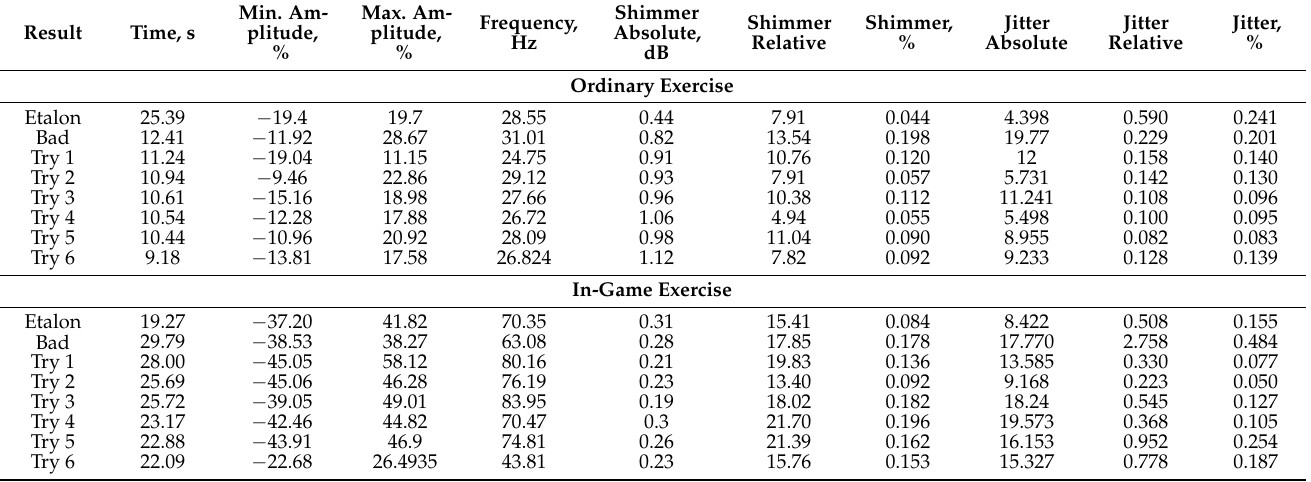
Table 7. The results obtained from Exercise 4 in its two interpretations: game and usual.